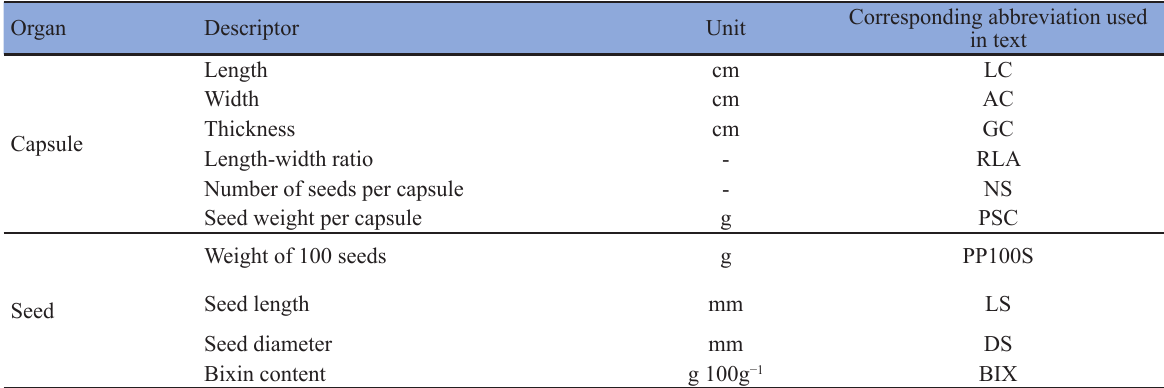
Table 2 . Quantitative descriptors used to characterize achiote ( Bixa orellana L.) accessions.